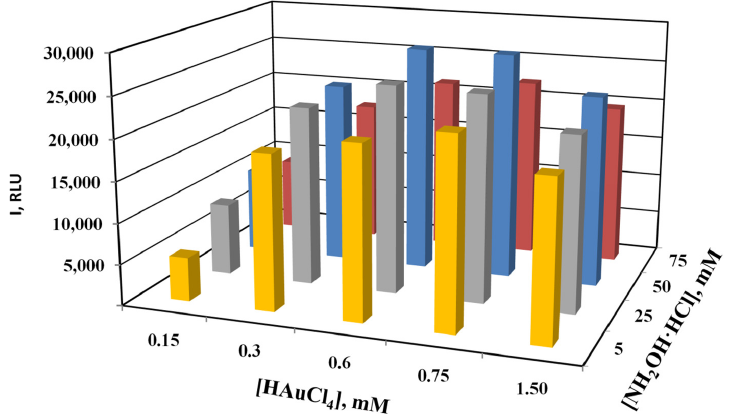
Figure 7. Diagram of the staining of specific spots on the concentration of reagents in the enhancement solution at pH 3.5.